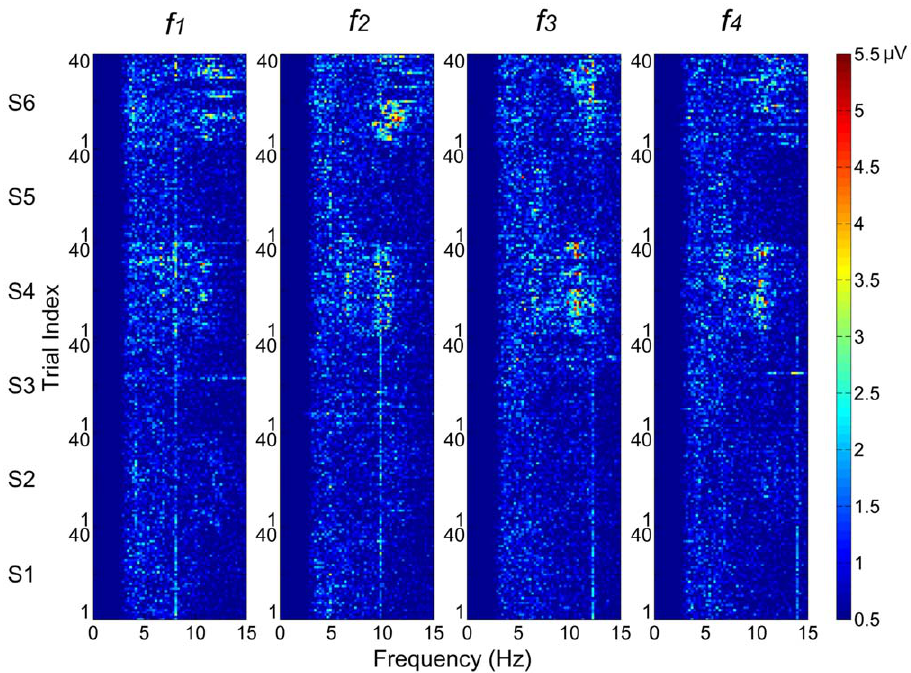
Figure 4. Image plot of amplitude spectra of SSMVEPs ( f 1 – f 4 ) on Oz site. Consecutive non-overlapped trials were sorted by ordinal run order from subject S1 to subject S6.